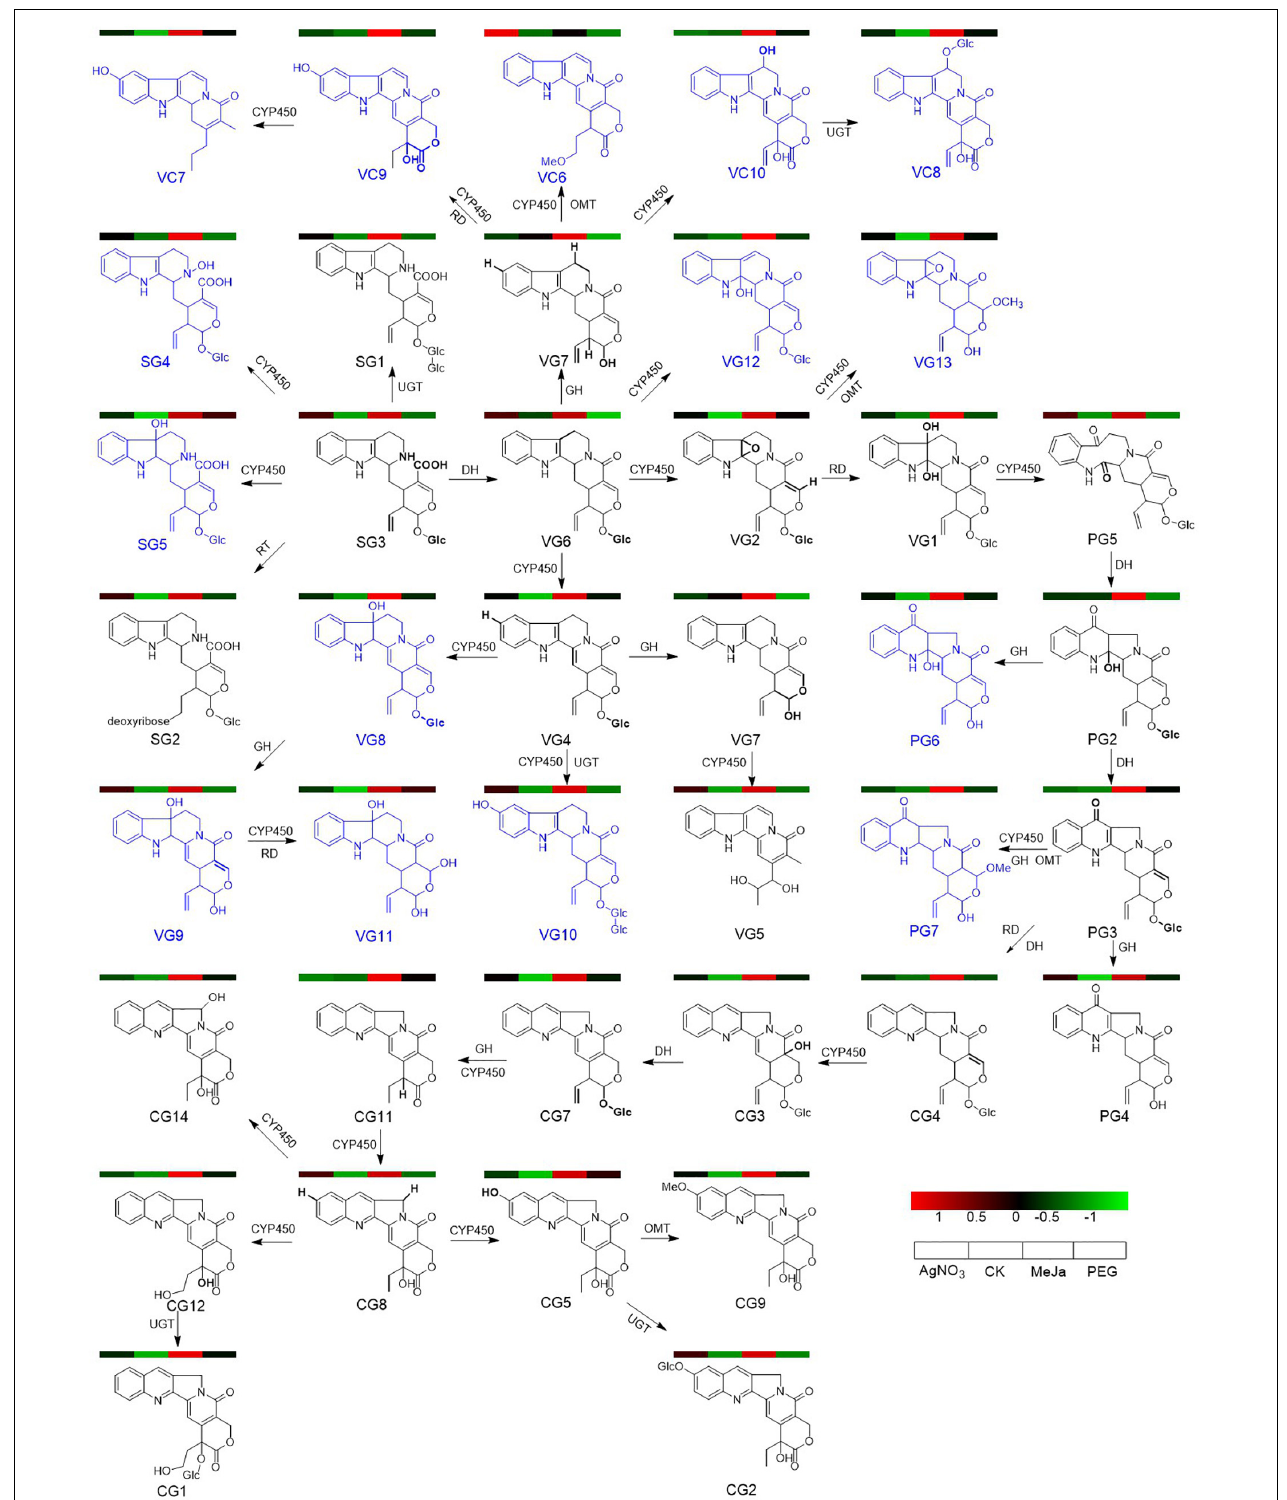
FIGURE 5 | A detailed metabolic map of the 40 identified alkaloids in C. acuminata plantlets after elicitation treatment. New alkaloids are marked in blue, and their enrichment patterns are illustrated in the heat map. The catalytic site of each step is marked in bold. DH, dehydratase; CYP450, cytochrome P450; CPR, cytochrome P450 reductase; EH, epoxide hydrolase; RD, reductase; GH, glucose hydrolase; UGT, UDP-glucosyltransferase; OMT, O-methyltransferase.